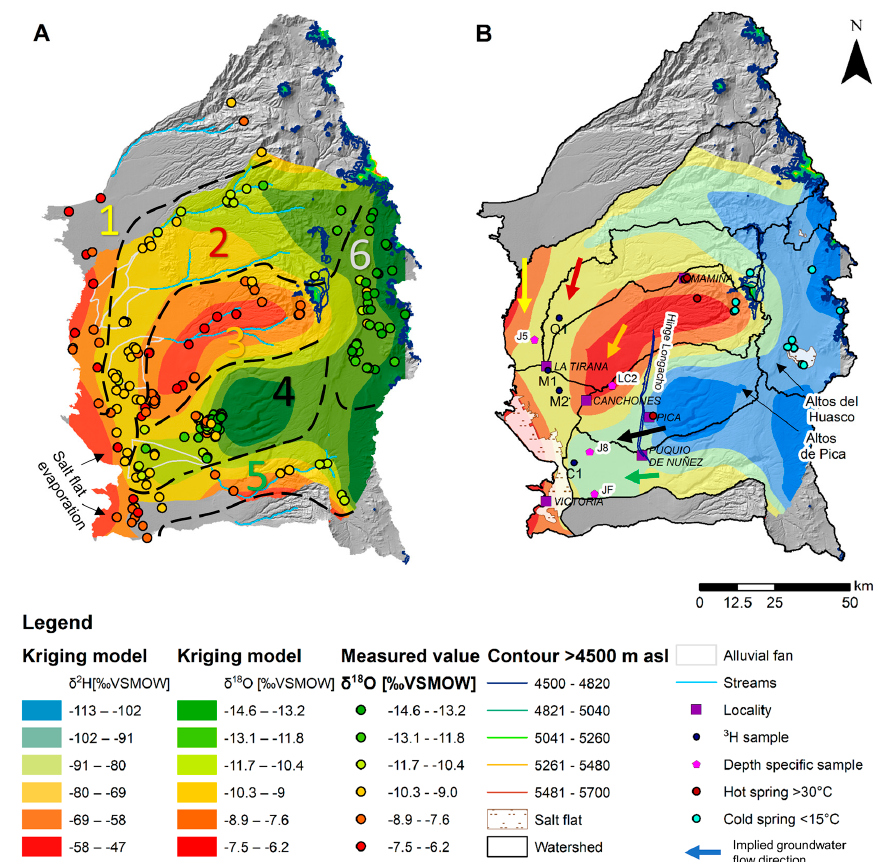
Figure 2. ( A ) Kriging model based on δ 18 O values in river, ground and spring water and yielded meteoric water compartments 1–6 (limits marked by dashed lines), ( B ) Kriging model based on δ 2 H data of river, ground and spring water and implied groundwater flow directions. Note that the extension of the alluvial fans at CP 3 and CP 5 is not corresponding with the respective groundwater flow direction (Figure 1B).